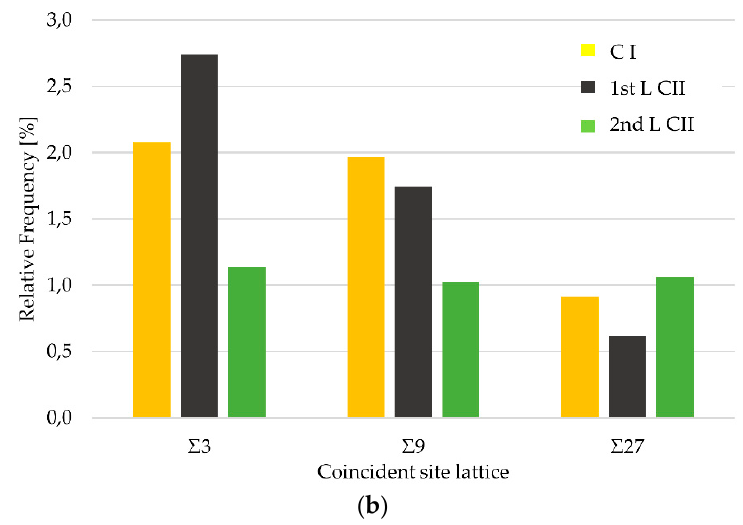
Figure 15. Relative frequencies of misorientation angles in the substrate, coarse grain heat affected the zones of clad I and clad II (HAZ C I and HAZ C II, respectively), clad I (C I), and the first and second layers of clad II (1st L C II and 2nd L C II, respectively) ( a ), and relative frequencies of special grain boundaries in the clads, determined by dividing the length fraction of the special grain boundaries by those of the other grain boundaries ( b ).